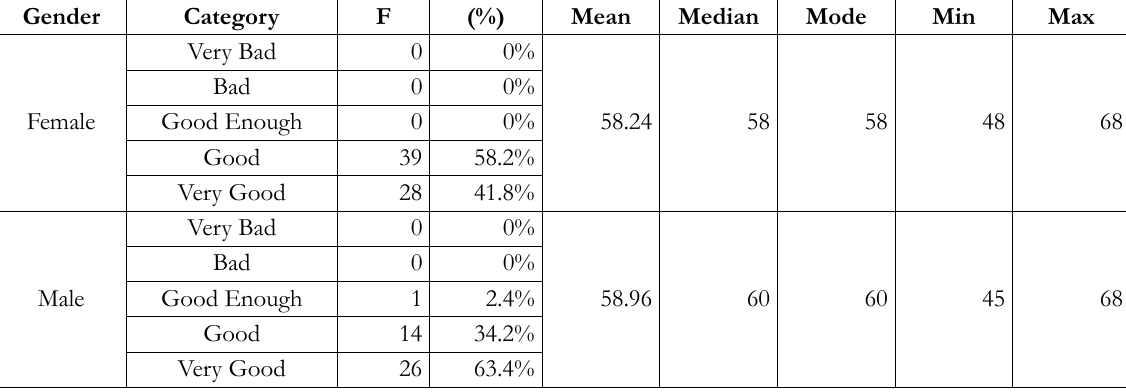
Table 13. Character Description of Eighth Grade